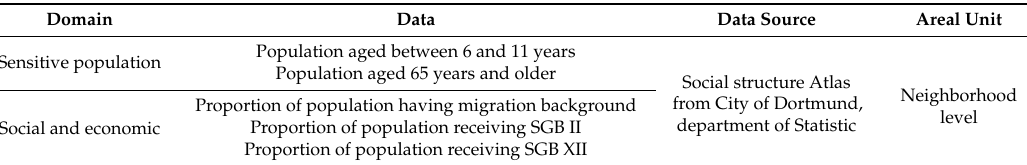
Table 4. Data characteristics and sources for social